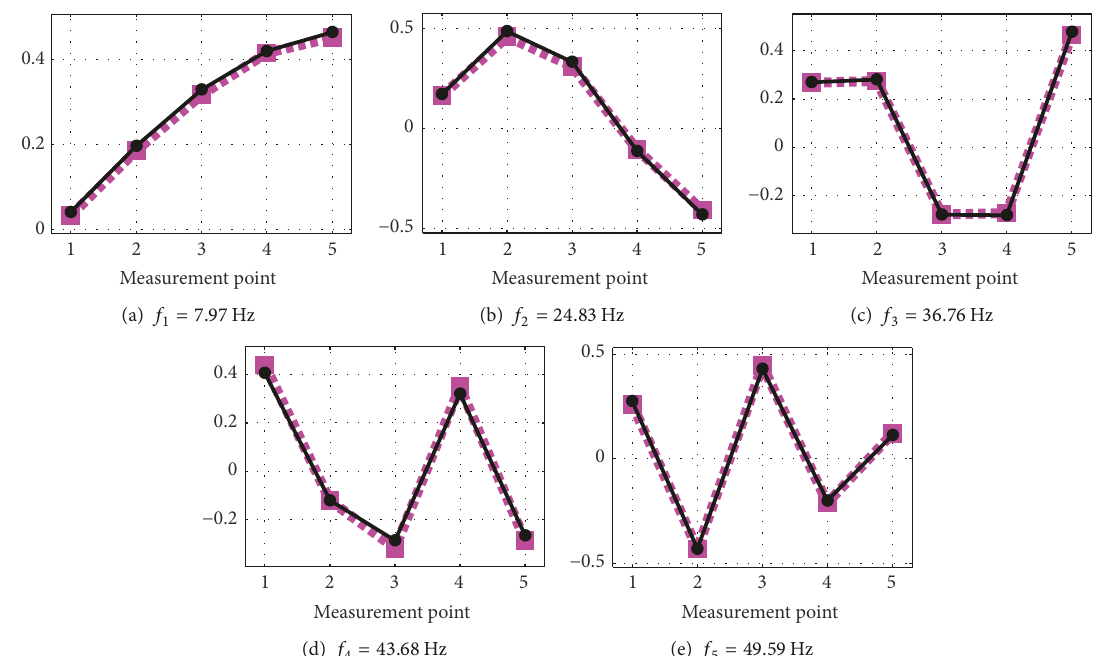
Figure 6: Mass-scaled mode shapes obtained using EMA (light, thick, and dashed lines) and the proposed method (dark, thin, and solid